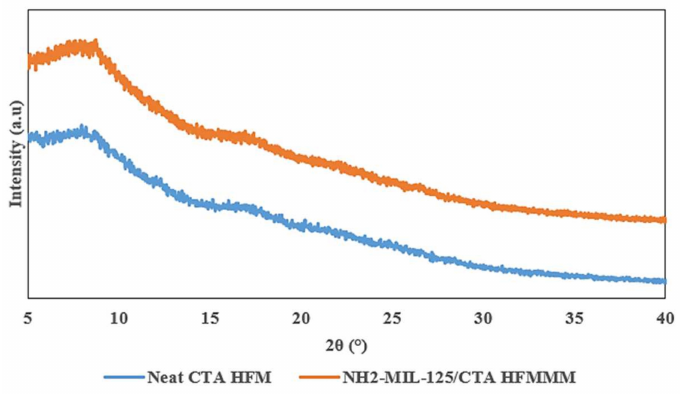
Figure 4. XRD pattern of CTA HFM and NH 2 -MIL-125(Ti)/CTA HFMMM.